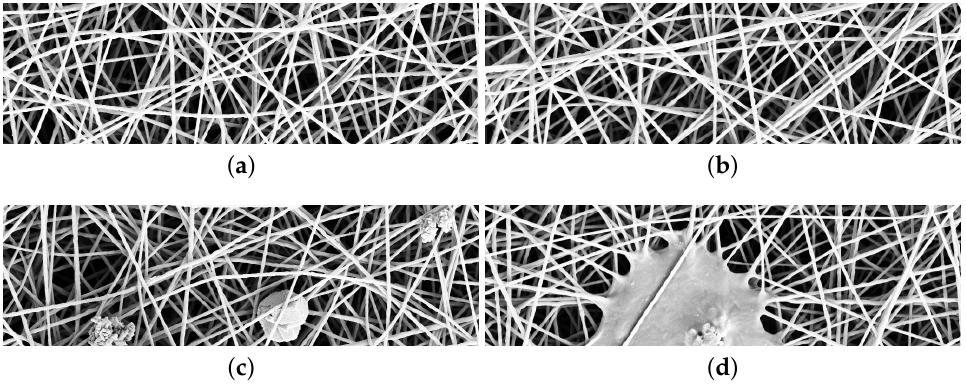
Figure 1. SEM images of nanofibrous materials. ( a , b ) samples without anomalies; ( c , d ) samples containing fine- and coarse-grained